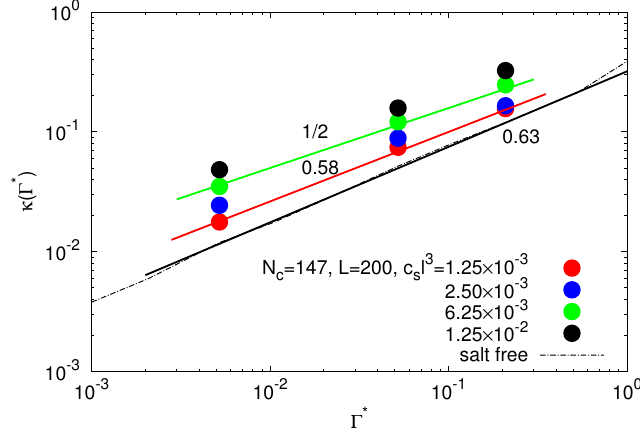
Figure 7. Inverse Debye screening length as a function of the scaled interaction strength for microgels with N c = 147 crosslinks, L / l = 200 and various salt concentrations. The dashed line represents the salt-free